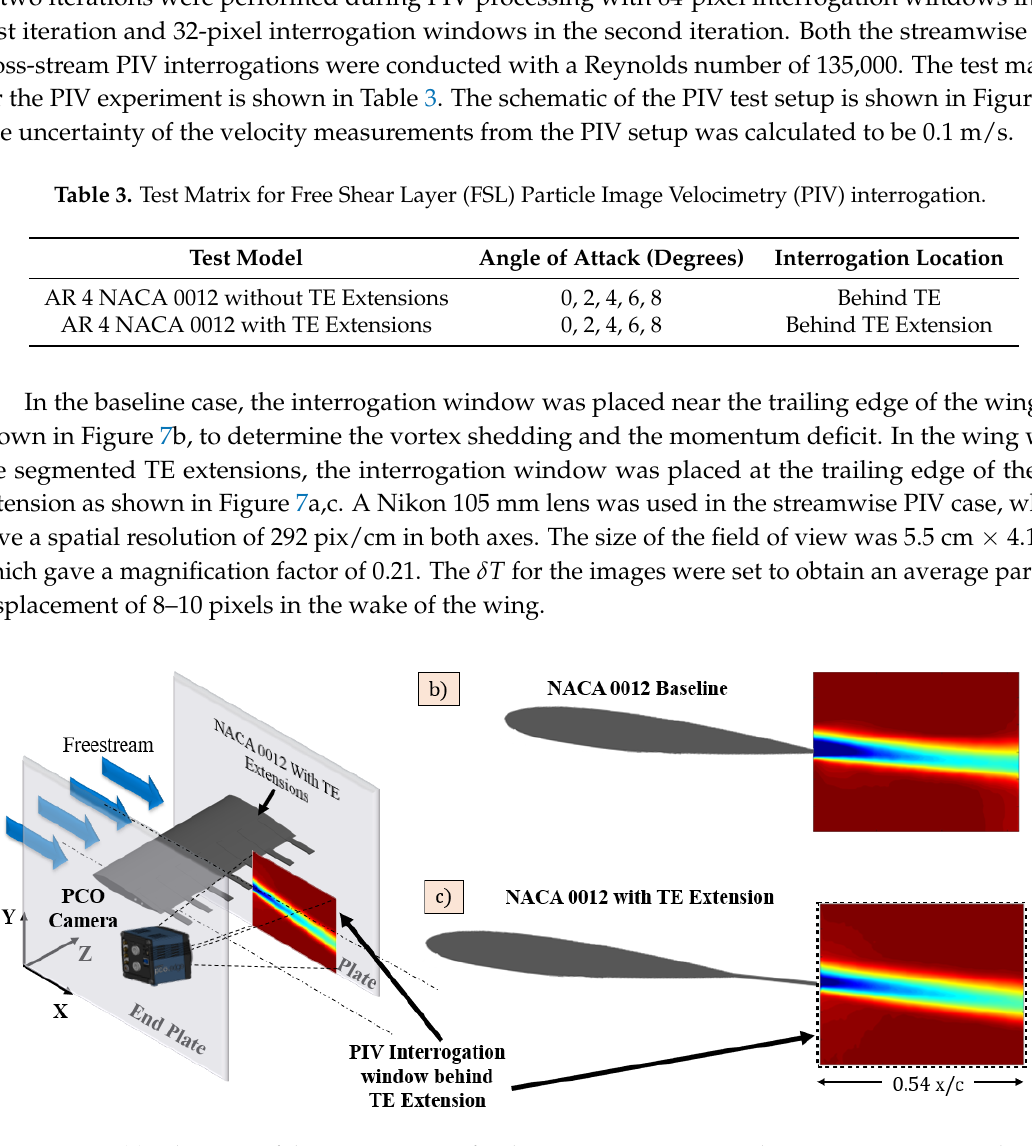
Figure 7. ( a ) Schematic of the PIV test setup for the NACA 0012 wing with TE extensions. A similar setup is used for the baseline wing. The PIV interrogation window for ( b ) the baseline case was located at the TE and ( c ) for the wing with the TE extension, it was location at the trailing edge of the